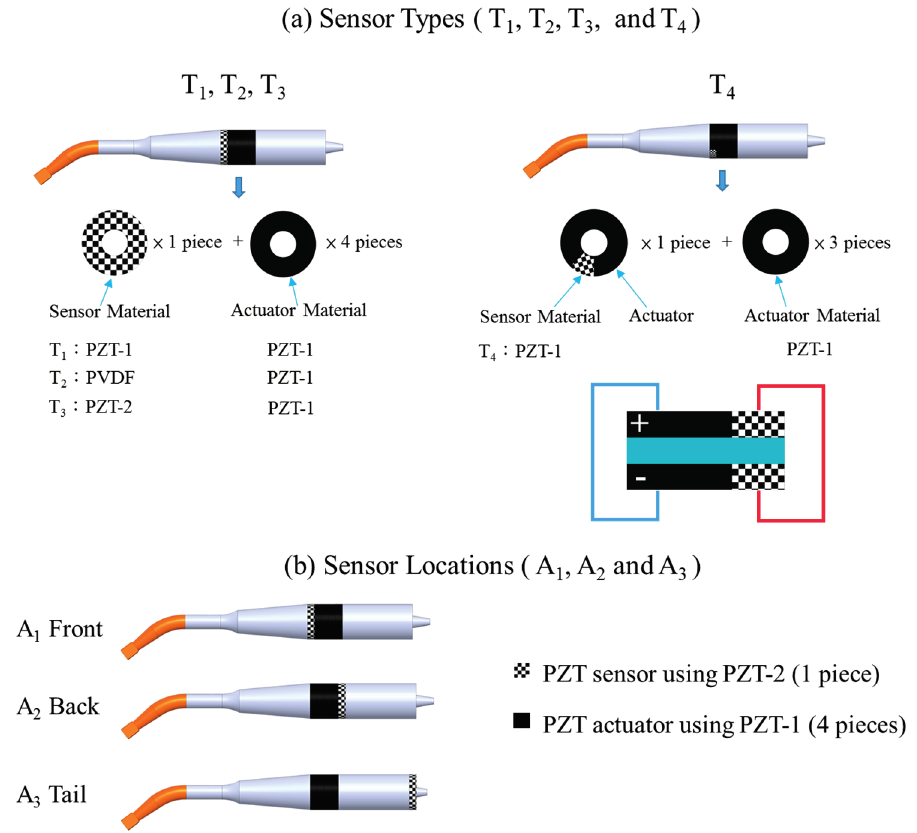
Figure 2. Illustration of ( a ) sensor types and ( b ) sensor